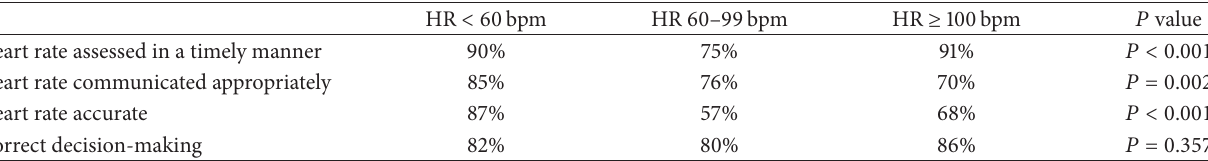
Table 3: House officers’ performance on high fidelity neonatal simulation heart rate assessment measures according to actual heart